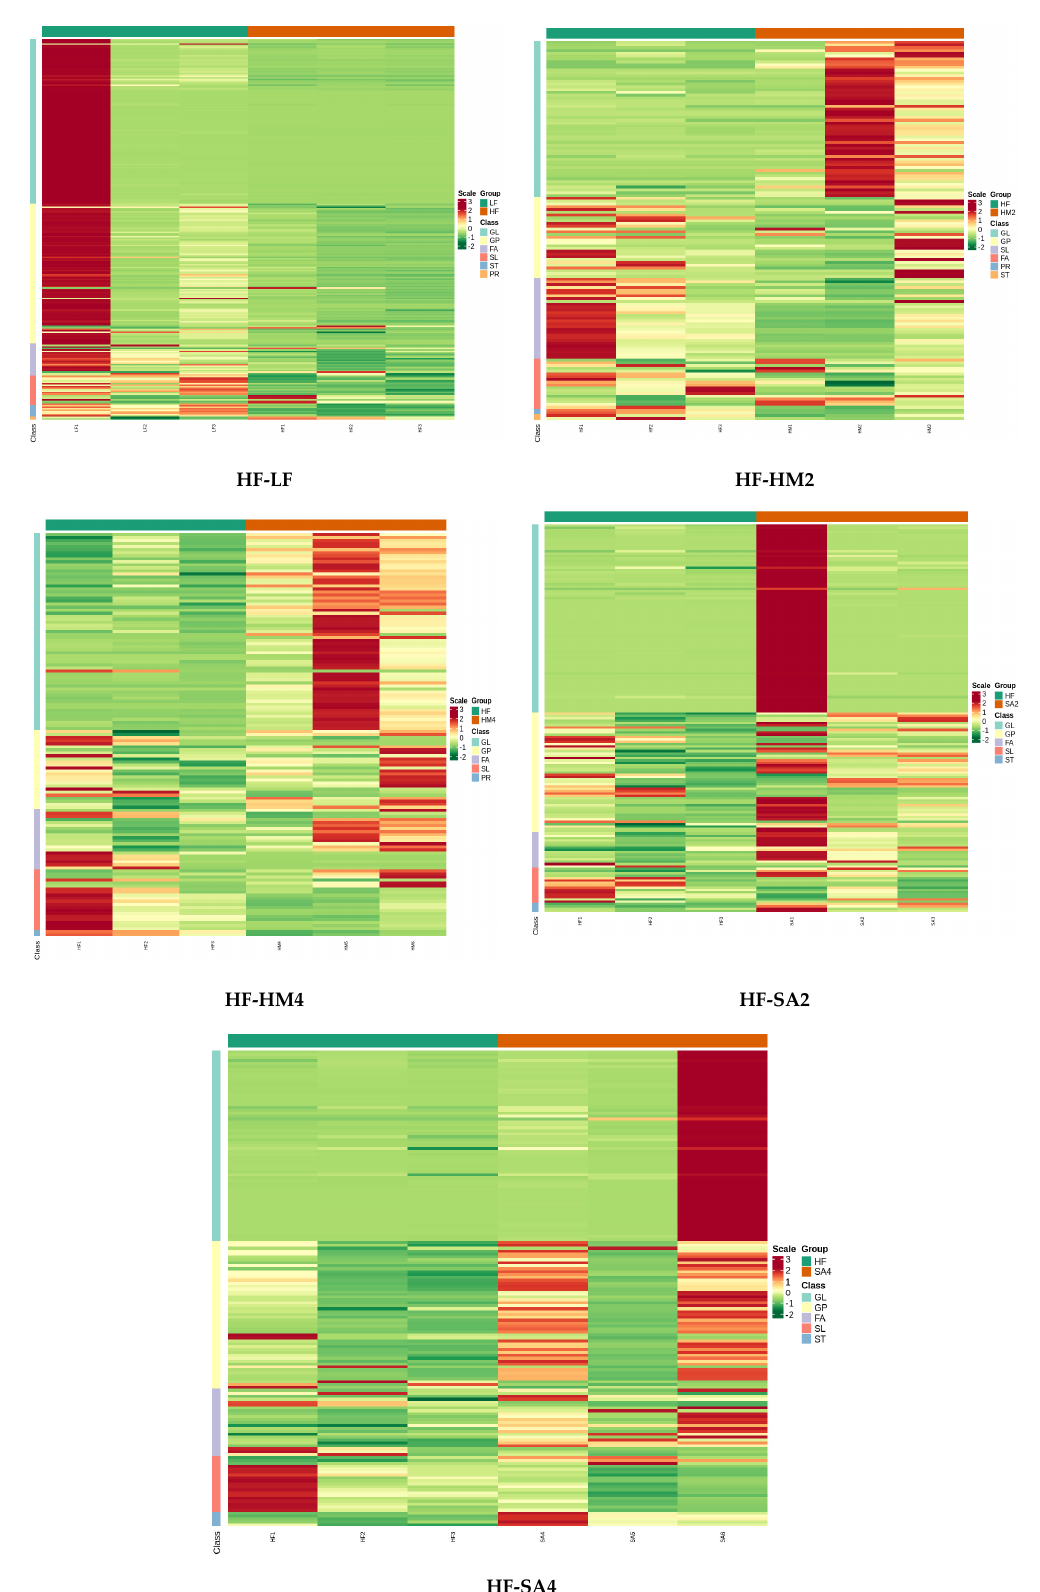
Figure 3. The horizontal is the sample information, the longitudinal is the metabolite information, the cluster tree on the left side of the figure is the metabolite cluster tree, the scale is the expression obtained after the standardized treatment (the higher the expression of the color, the higher the redness), and the group is the grouping.